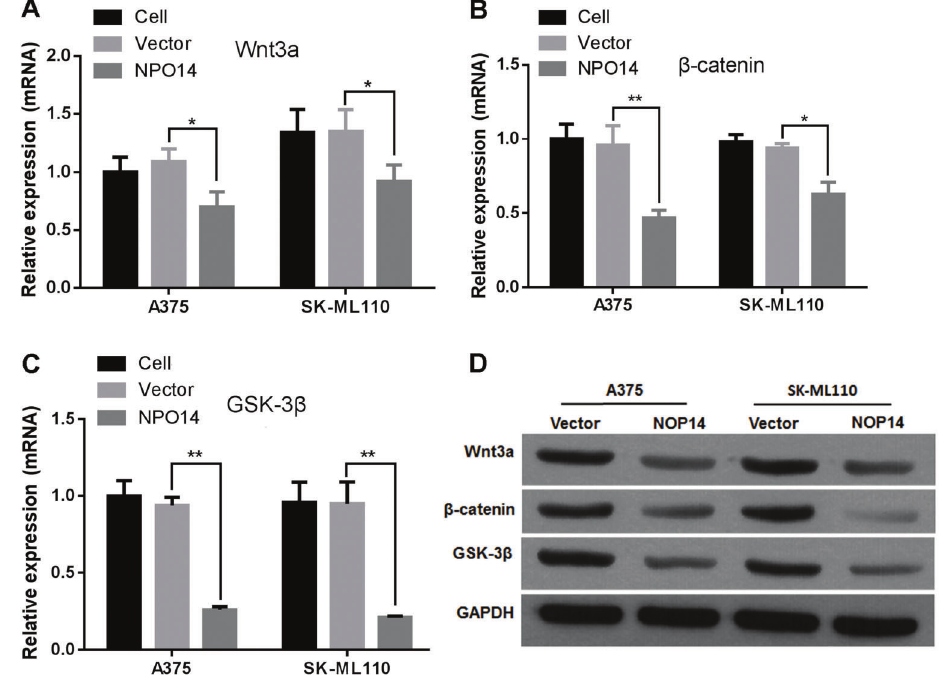
Figure 5. Expression level of Wnt3a, b -catenin, and GSK-3 b in melanoma cells. A to C , Relative expression and D , protein levels of Wnt3a, b -catenin, and GSK-3 b in melanoma cells transfected with nucleolar protein 14 (NOP14) overexpression and empty vectors. Data are reported as means ± SD. *P o 0.05, **P o 0.01 vs empty vector